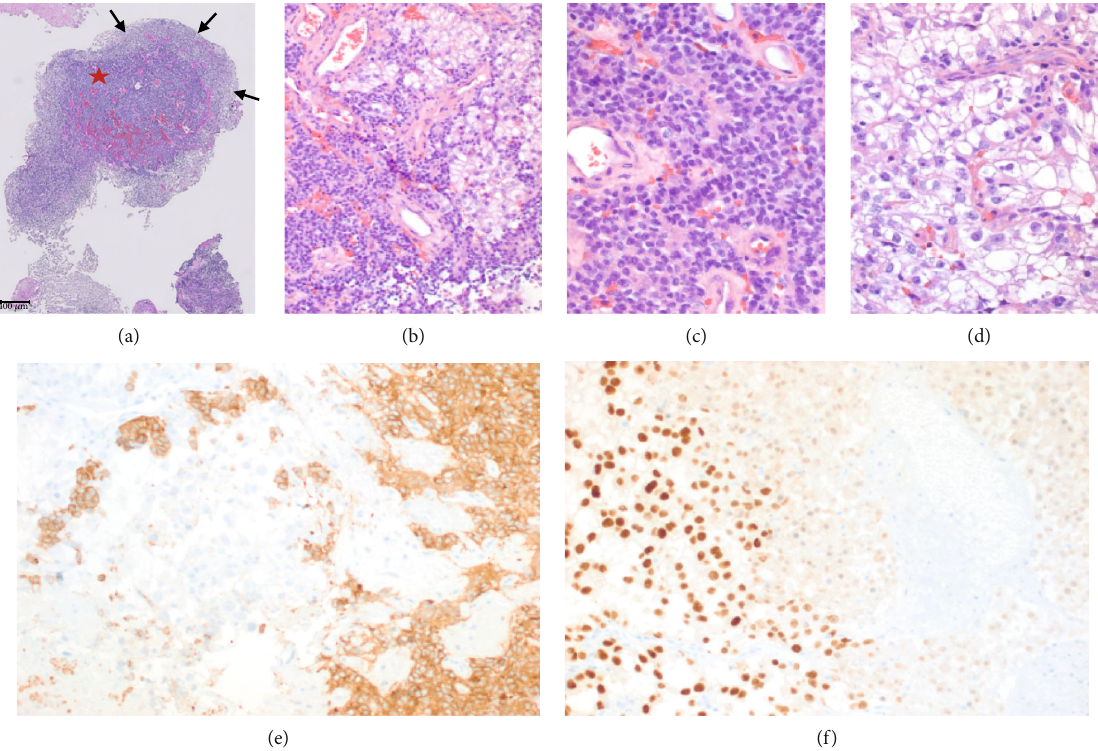
Figure 5: (a) Admixed pituitary adenoma (star) and the surrounding metastatic carcinoma (arrows) in one of the fragments. (b) Juxtaposition of pituitary adenoma (lower left) and metastatic renal cell carcinoma (upper right). (c) Pituitary adenoma shows sheets of cytologically bland, monotonous cells. (d) Renal cell carcinoma shows large atypical cells with prominent nucleoli and clear cytoplasms. (e) Synaptophysin is positive in the pituitary adenoma and negative in the renal cell carcinoma. PAX-8 shows nuclear positivity in the renal cell carcinoma, while the pituitary adenoma is negative. (a – e) Hematoxylin-eosin. (d, e) Immunohistochemistry. Original magni fi cations: (a) 20x; (b, e, f) 200x; and (c, d)